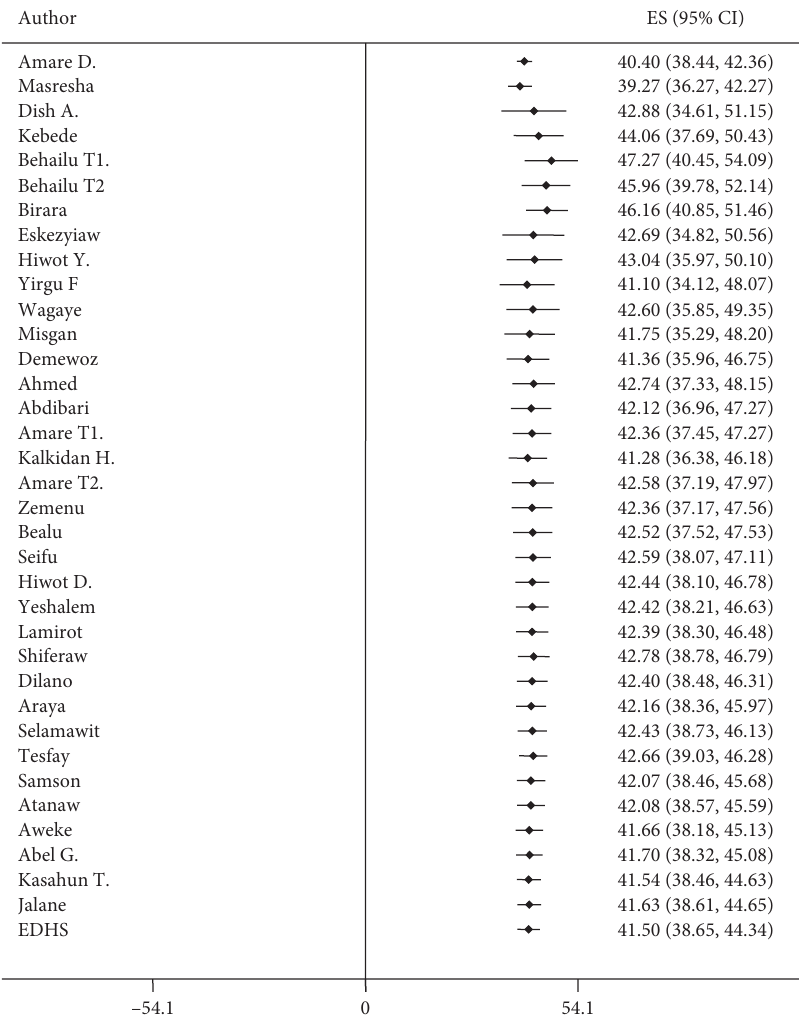
Figure 3: Trends of stunting from 2010 to 2019 using cumulative meta-analysis in